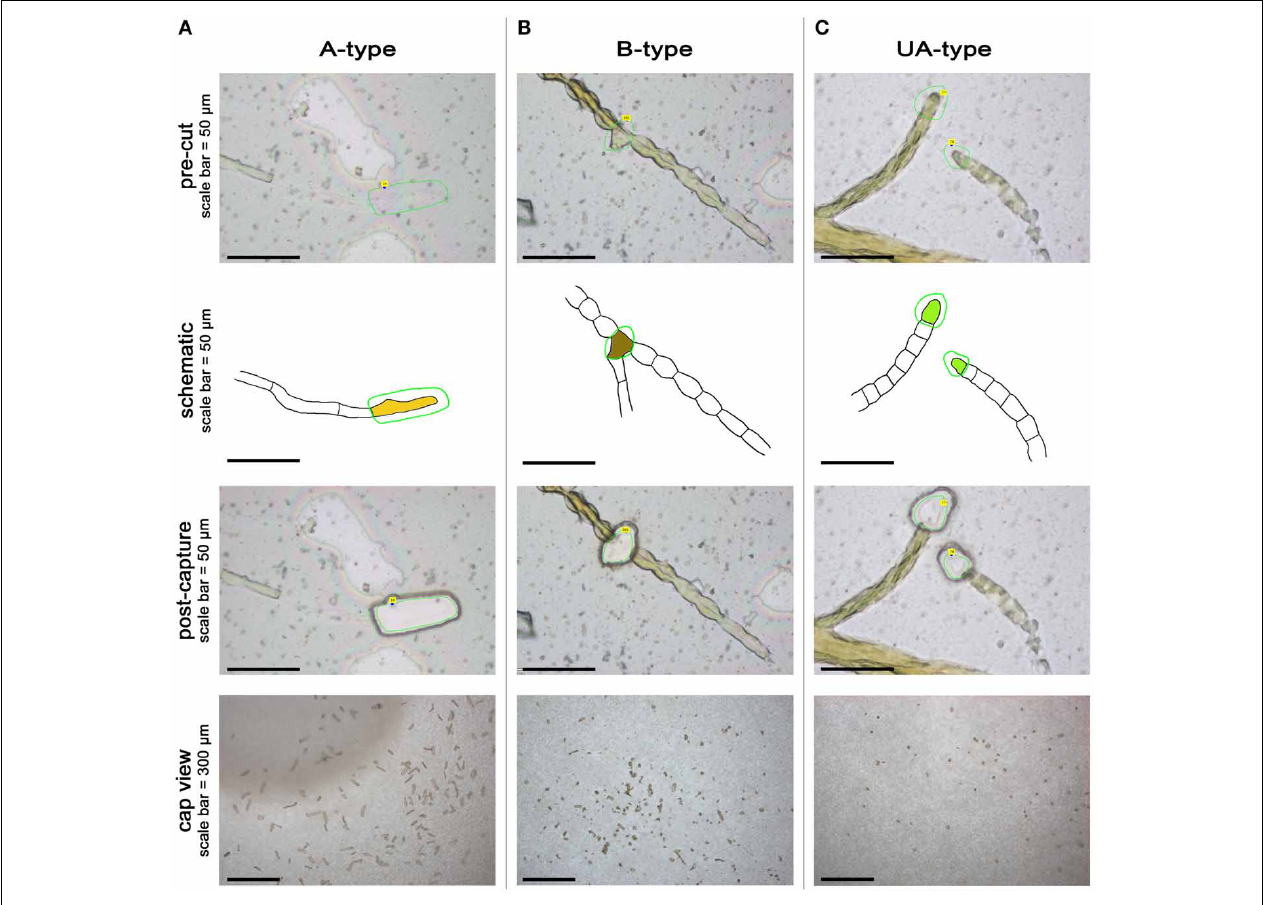
FIGURE 3 | Laser capture microdissection of Ectocarpus cells. Pre-cut, associated schematic, post-capture and cap view for A-type (A) , B-type (B) , and UA-type (C) cells. Green line represents the laser track in PalmRobo